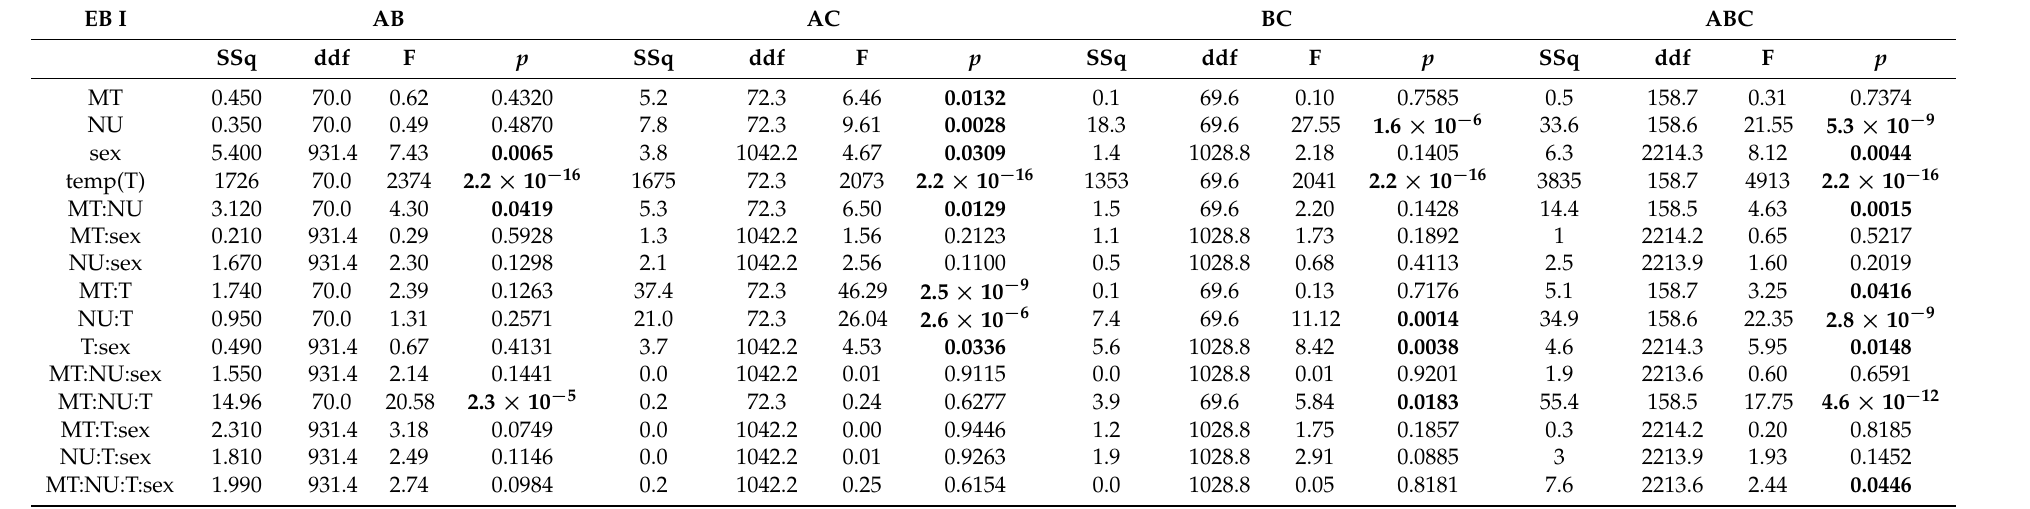
Table 6. The effect of mitochondrial haplotype (MT), nuclear genetic background (NU), sex, temperature (T) and their interactions on developmental time for the three pairwise comparisons from experimental block (EB) I and the whole EB I of D. obscura . SSq, sum of squares; ddf, denominator degrees of freedom; p values that are significant at p < 0.05 are given in bold.